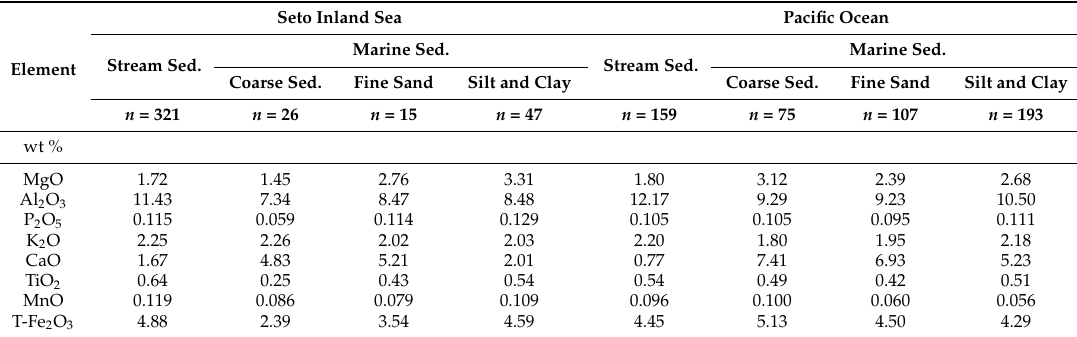
Table 3. Median elemental concentrations of marine sediments and stream